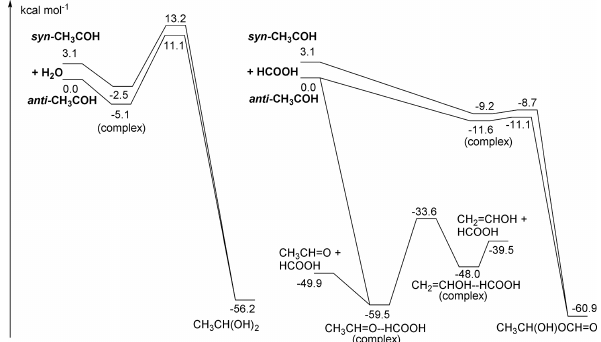
Figure 5. ZPE-corrected potential energy surface for reactions of singlet CH 3 COH with H 2 O (left) and HCOOH (right) at the CCSD(T)//M06-2X-D3 level of